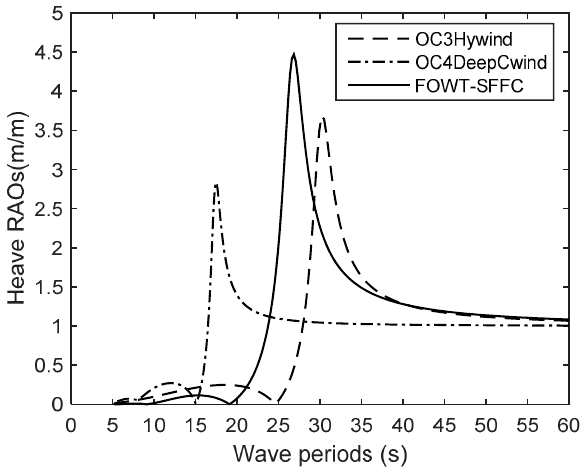
Figure 5. Heave response amplitude operators (RAOs) of three concepts of offshore wind turbines.